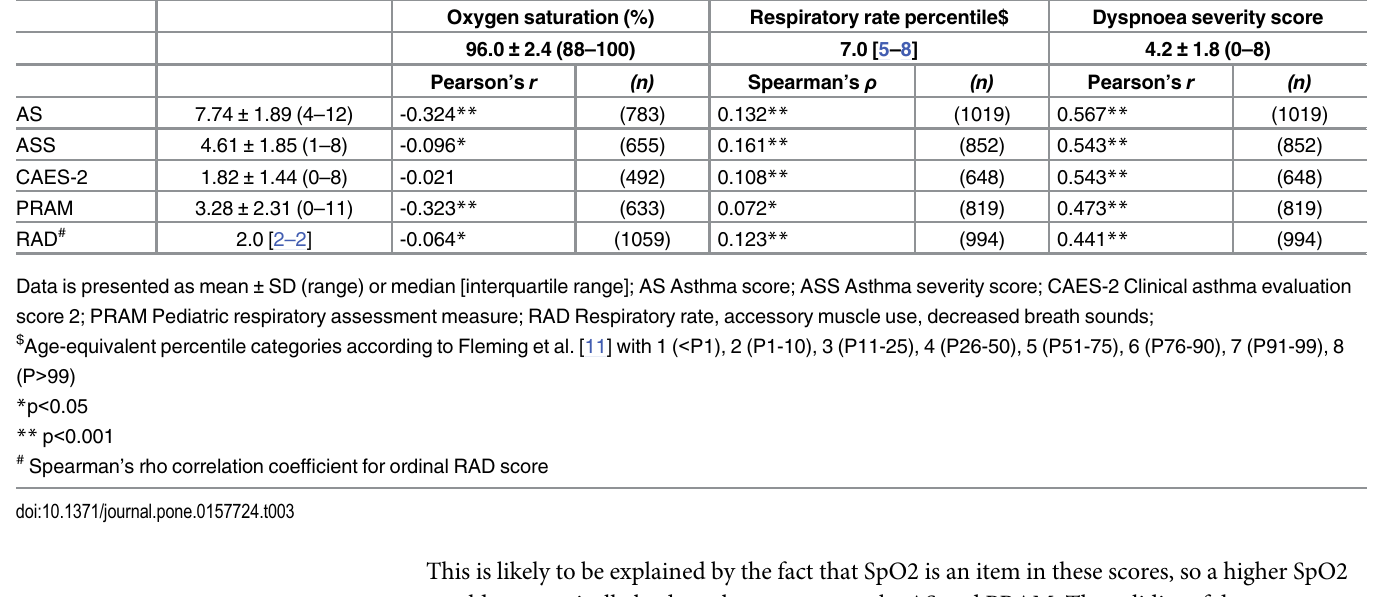
Table 3. Concurrent validity of five dyspnoea scores by correlating total scores with oxygen saturation, Fleming ’ s respiratory rate percentile and the dyspnoea severity score.